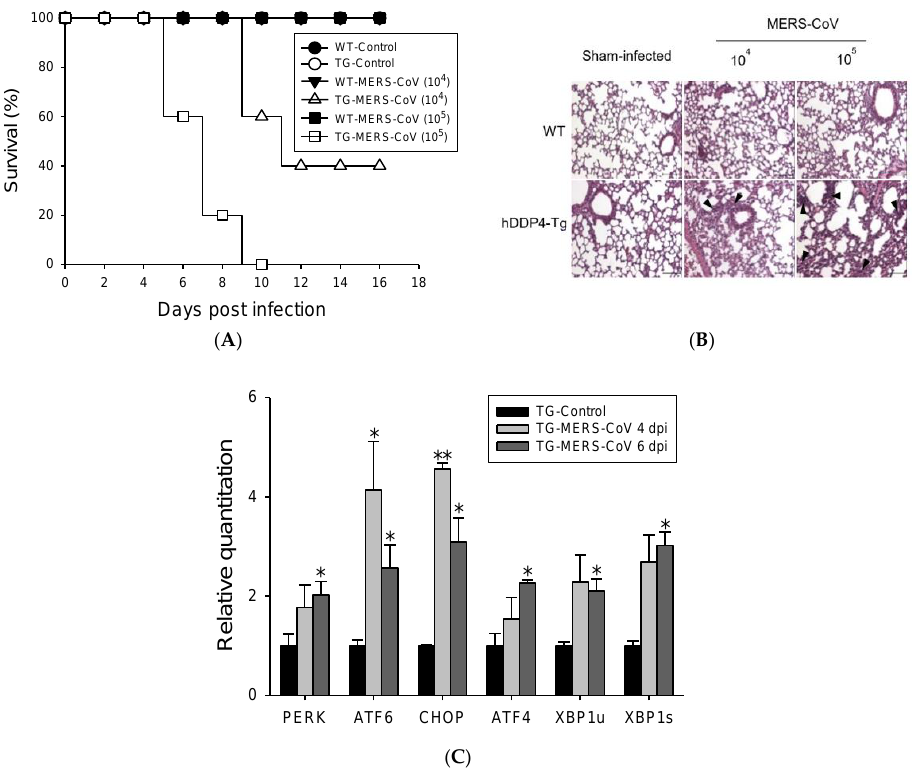
Figure 1. MERS-CoV infection in hDPP4-Tg mice causes mortality and morbidity with progressive pulmonary fibrosis. hDPP4-Tg mice and transgene-negative littermates were challenged intranasally with MERS-CoV (10 4 or 10 5 plaque-forming unit (PFU)) or phosphate-buffered saline (PBS). Infected